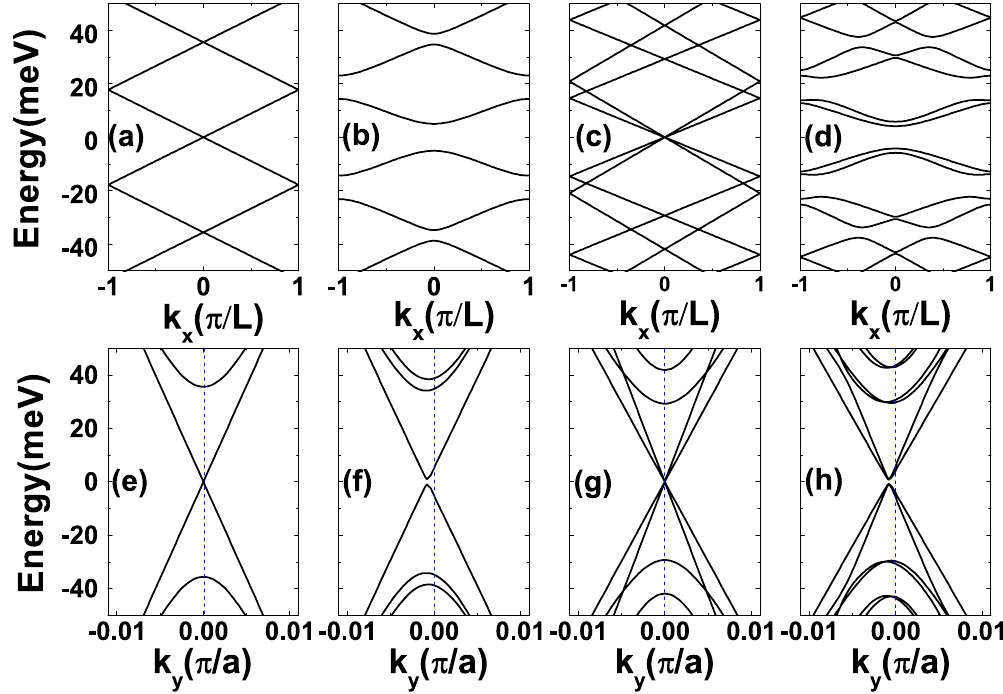
Figure 2. ( a–d ) The energy dispersions as a function of the wave vector k x (in units of π / L ) when k y = 0. ( a ) B = 0, R 0 = 0; ( b ) B = 1 T , R 0 = 0; ( c ) B = 0, R 0 = 10 2 m / s ; ( d ) B = 1 T , R 0 = 10 2 m / s . The corresponding energy dispersions as a function of the wave vector k y are plotted in ( e–h ) when k x =